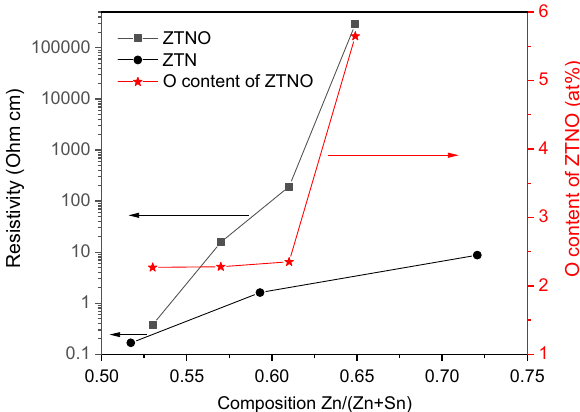
Figure 6: Resistivity vs cation composition Zn/ ( Zn + Sn ) of ZTNO and ZTN thin fi lms on glass substrates grown by chambers with back - ground vacuum of 10 − 3 and 10 − 7 Pa, respectively. The oxygen anion composition of ZTNO thin fi lms is also plotted as a function of Zn/ ( Zn + Sn ) ( authors ’ original work )